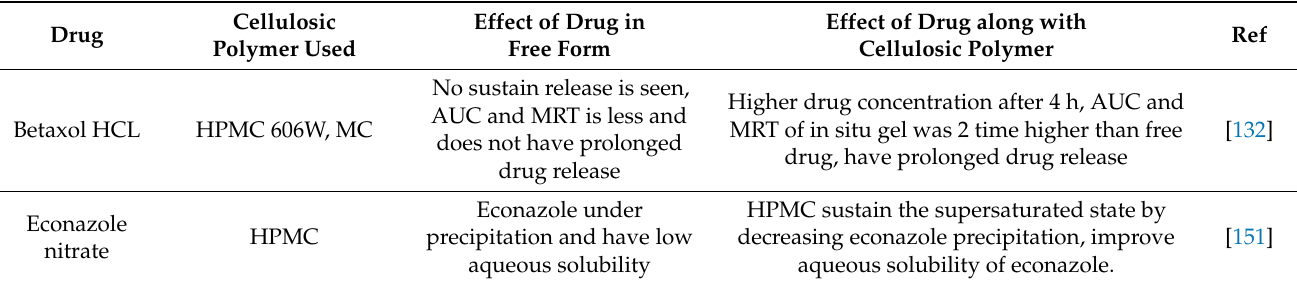
Table 5. Comparison between of Free form of Drug and Drug with Cellulosic